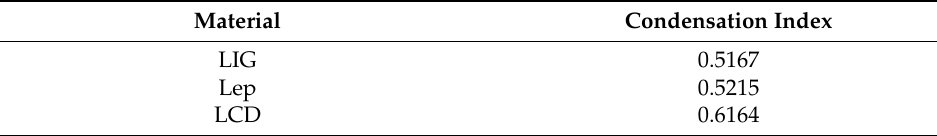
Table 1. Condensation index for the base matrix.